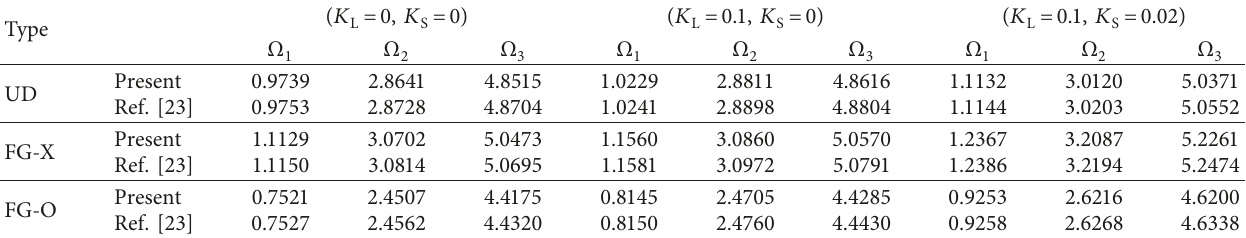
Table 3: Comparison of the first three dimensionless linear frequency parameters for CNTRC beams resting on linear elastic foundations � 0.12, L / H � 15, H � 0 . 1m, and K � 0; boundary condition: H-H). ( V ∗ NL CNT